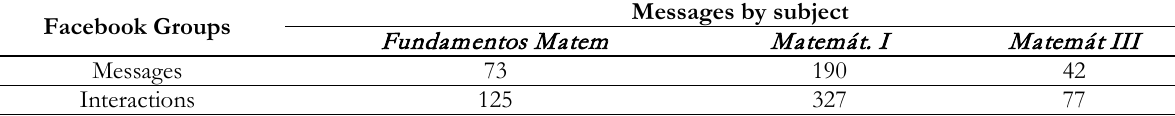
Table 1. Other aspects to consider with the total group of students Facebook